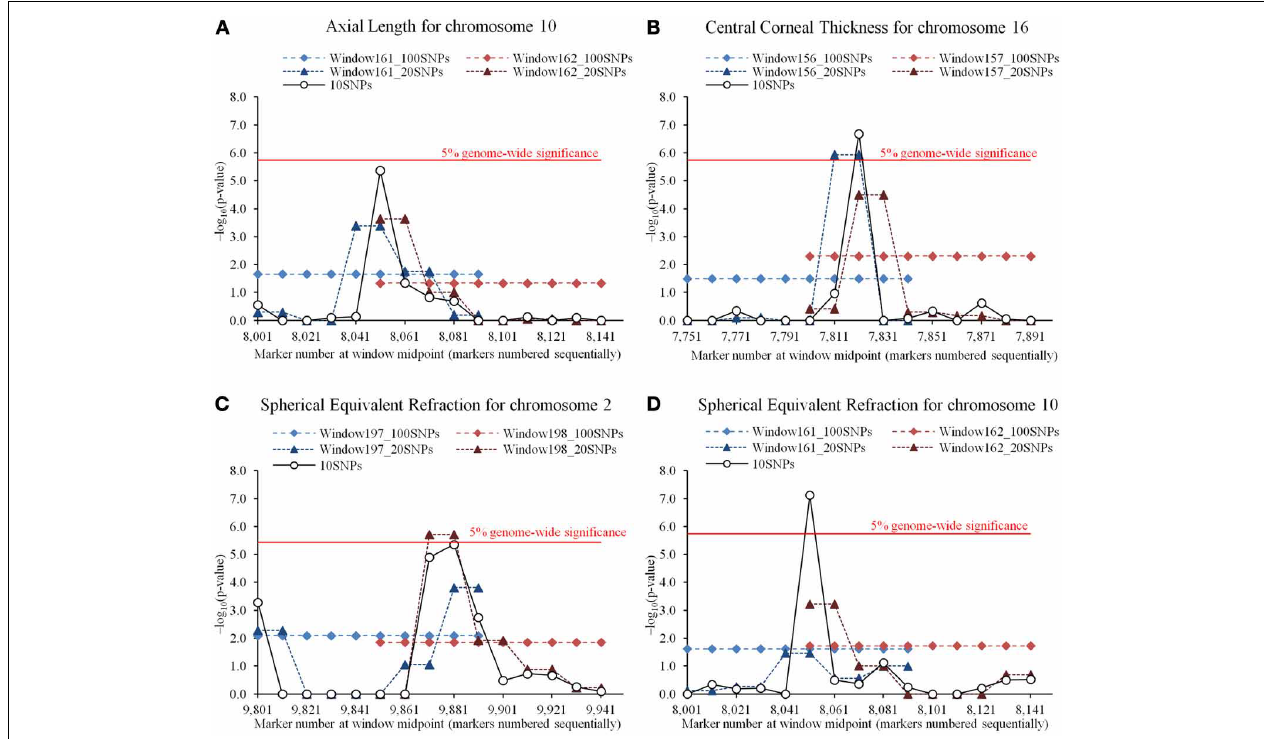
FIGURE 5 | Comparisons of regional heritability mapping (RHM) among different window sizes on a significant region for three eye traits. Comparisons shown on the results of higher − log 10 ( P -value) ( > 5.0) for axial length (AL), central corneal thickness (CCT), and spherical equivalent refraction (SER). (A) The results of AL on chromosome 10. The plot shows the − log 10 ( P -value) of 100-SNP-window number 161 for RHM with win100 (Window161_100SNPs) and win20 (Window161_20 SNPs), 100-SNP-window number 162 for RHM with win100 (Window162_100SNPs) and win20 (Window162_20SNPs), and 100-SNP-window numbers 161 and 162 for RHM with win10 (10SNPs). The red horizontal line is drawn at the 5% genome-wide significance for RHM with win10. (B) The result of CCT on chromosome 16. The plot shows the − log 10 ( P -value) of 100-SNP-window number 156 for RHM with win100 (Window156_100SNPs) and win20 (Window156_20 SNPs), 100-SNP-window number 157 for RHM with win100 (Window157_100SNPs) and win20 (Window157_20SNPs), and